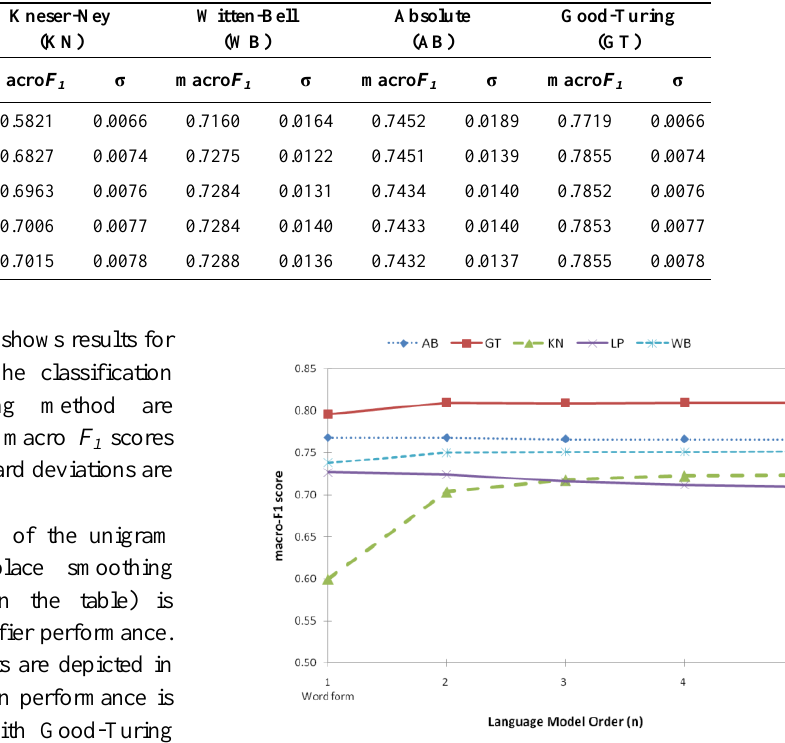
Table 5. Results for word form based